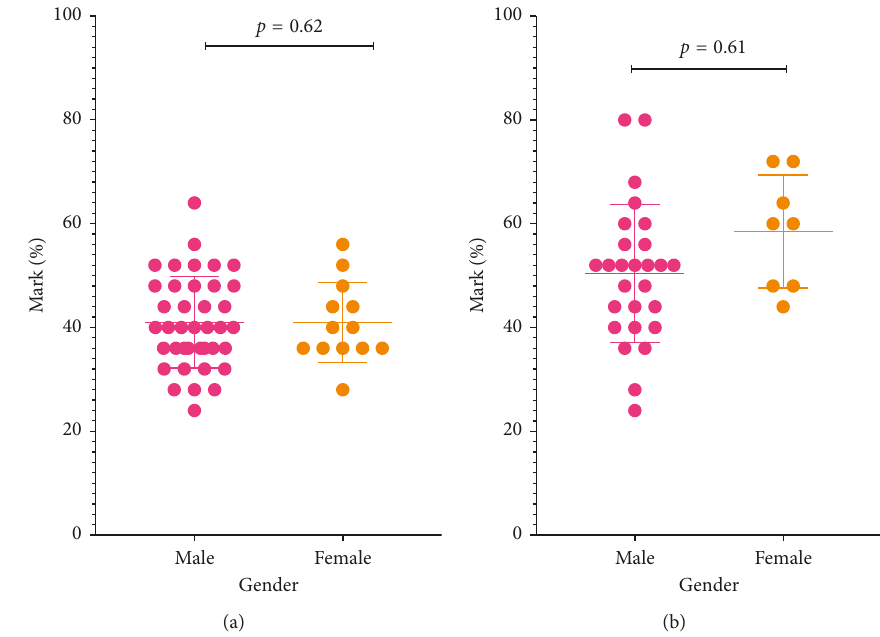
Figure 1: Examination scores . (a) Pretest and (b) posttest scores of the medical students stratified by